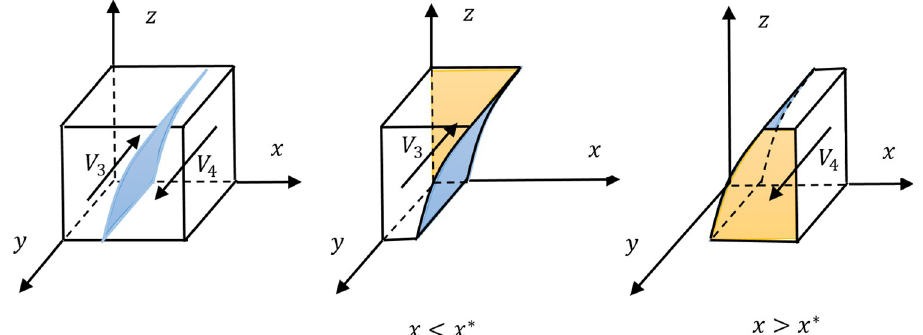
Fig 2. The evolution trend diagram of the informal